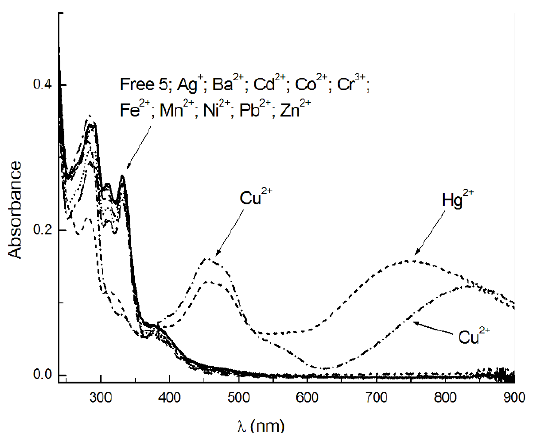
Figure 3. Absorption spectra of 5 (1.0×10 -5 M in CH